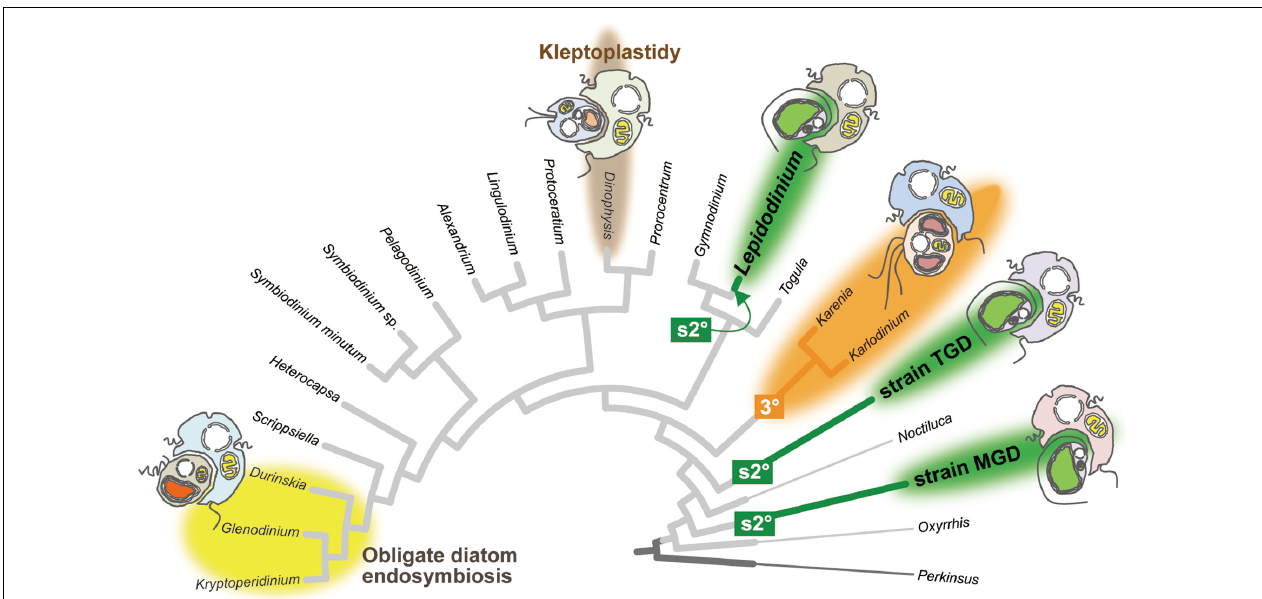
FIGURE 1 | Plastid evolution in dinoflagellates. The cladogram of 22 dinoflagellates and Perkinsus marina was prepared by modifying the phylogenetic tree inferred from a 75-protein alignment analyzed in Sarai et al. (2020). The branches of Lepidodinium , strain TGD, and strain MGD are colored in green, as their non-canonical plastids were yielded independently from pedinophycean endosymbionts (serial secondary endosymbiosis; labeled as “s2 ◦ ”). The clade of two kareniacean dinoflagellates, Karenia and Karlodinium , are colored in orange, as they possess the non-canonical plastids deduced from the endosymbiotic haptophyte (tertiary endosymbiosis; labeled as “3 ◦ ”). The clade of the dinoflagellates bearing obligate diatom endosymbionts are highlighted by a yellow background. The Dinophysis branch is highlighted by a brown background, as some members of the order Dinophysiales retain and utilize the plastids of prey algae temporarily (kleptoplastidy). Non-photosynthetic species are shown by thin